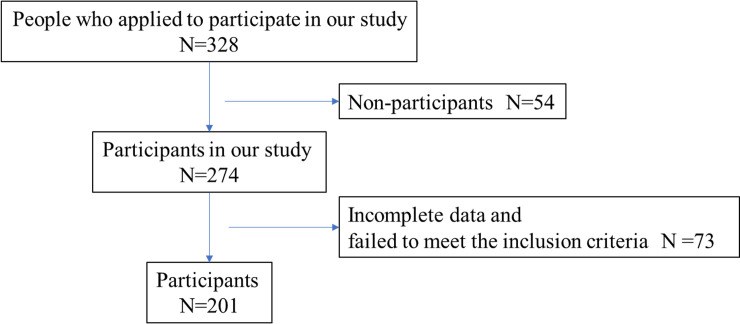
Flowchart of inclusion and exclusion criteria for this study.